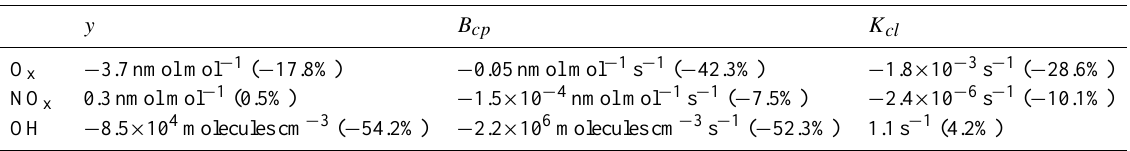
Table 6. The differences calculated as DUST J − NO DUST of the daily average mixing ratios ( y) and the gross chemical production rates ( B cp ) and the gross chemical loss frequencies ( K cl ) of O x , NO x and OH due to the decrease of photolysis rate coefficients for the T04 case. The relative differences calculated as (DUST J − NO DUST)/NO DUST are shown in parentheses. For OH, the concentration C is shown instead of the mixing ratio y .